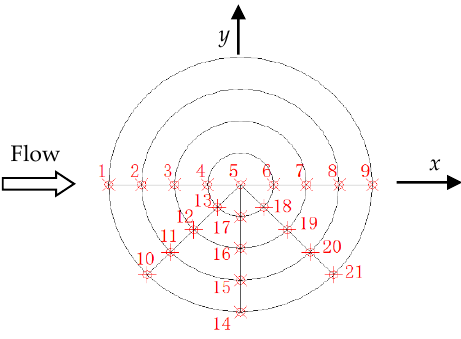
Figure 5. Layout of the test points.